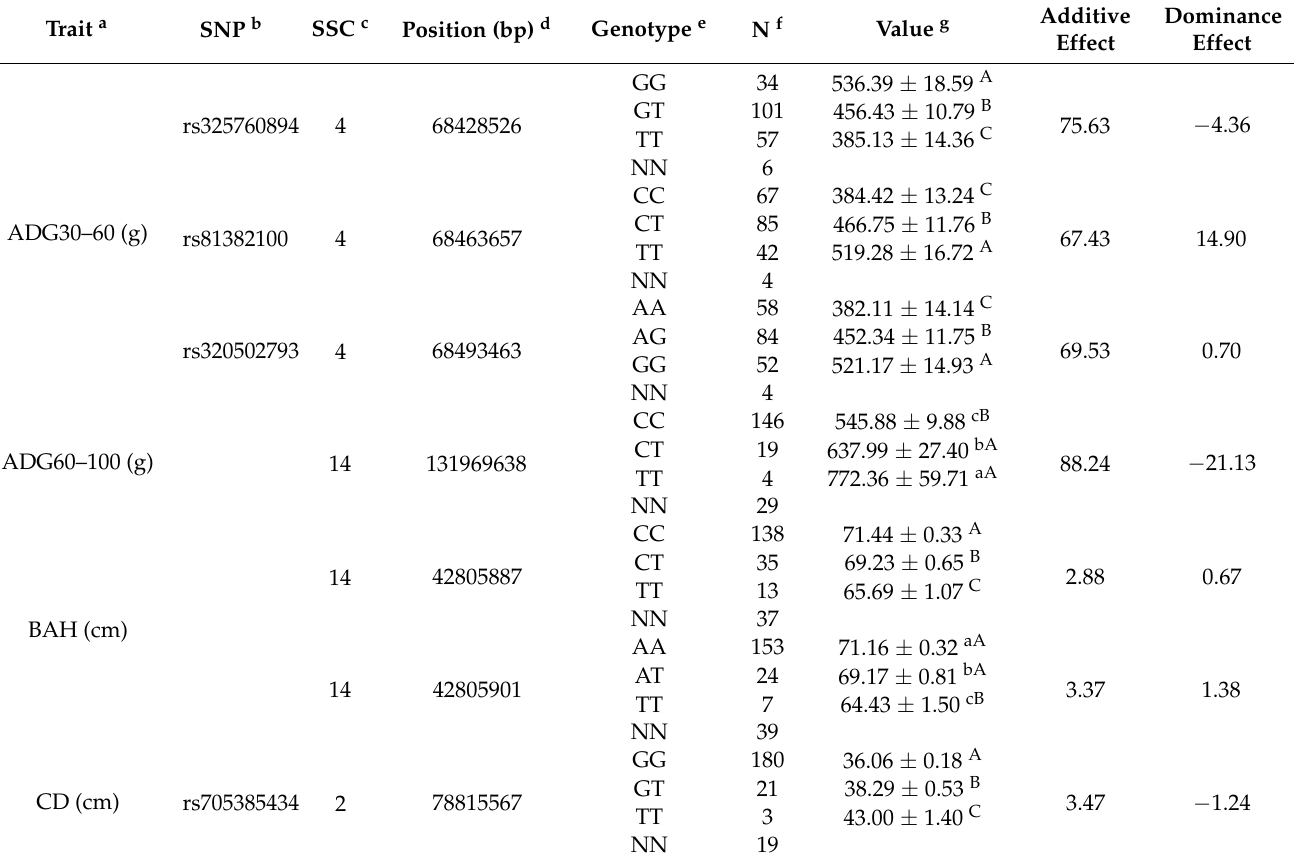
Table 3. Effect of the genotypes on growth